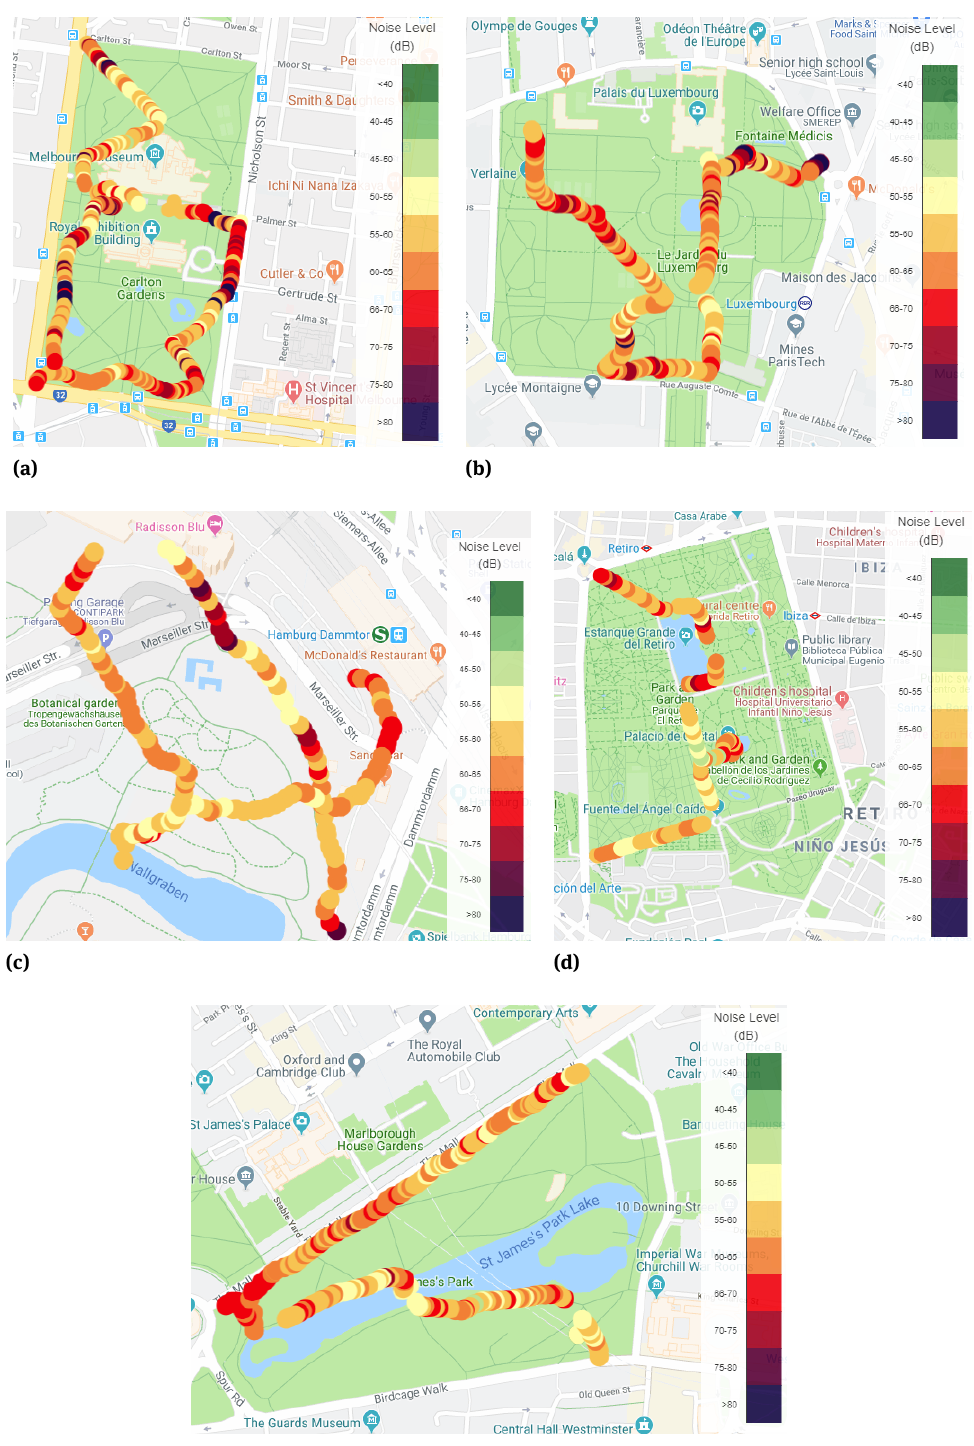
Figure 10: Sonic environment of five gardens. (a) Carlton Gardens Melbourne, (b) Luxembourg Gardens Paris, (c) Old Botanical Gardens Hamburg, (d) Real Jardin Botánico Madrid, and (e) St. James Park